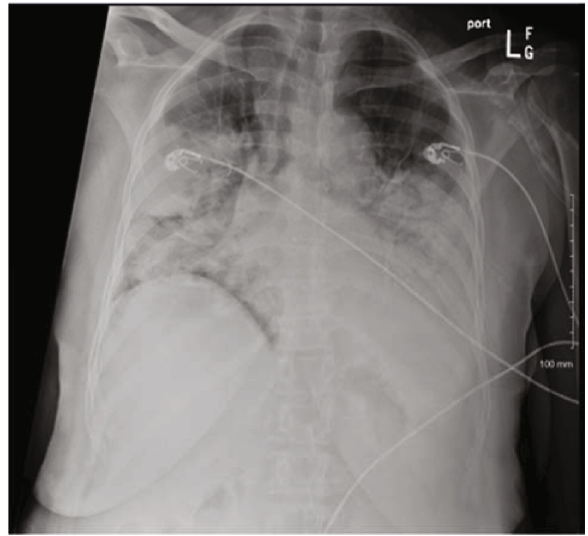
Figure 3: Chest X-ray: bilateral consolidations.